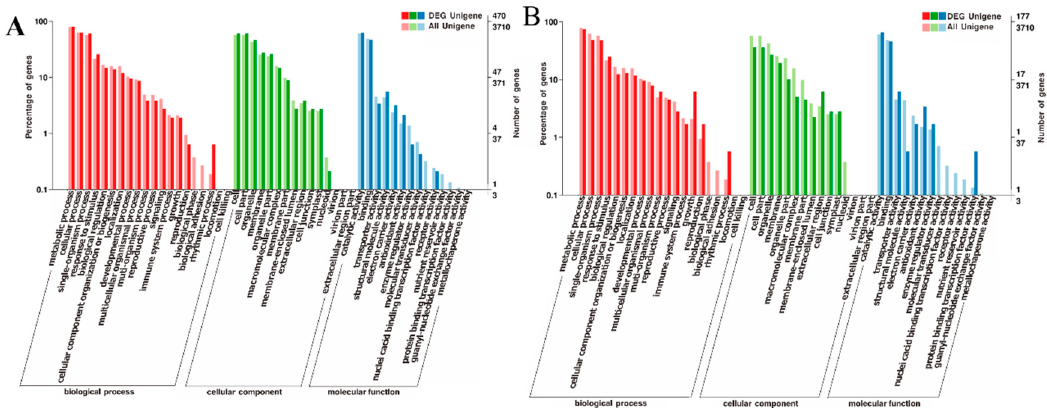
Figure 3. Ontology classification of di ff erentially expressed proteins (DEPs) in the S-D stressed mulberry leaves ( A ) and roots ( B ). The X -axis indicates GO terms, while the Y -axis indicates the percentage of